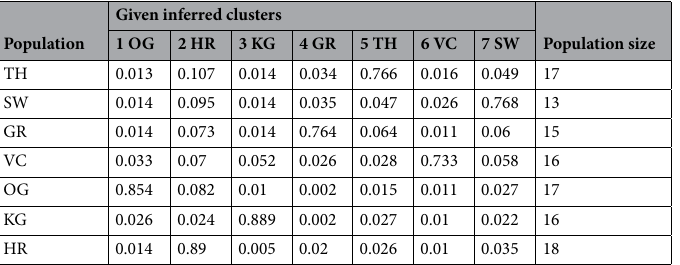
Given inferred Population